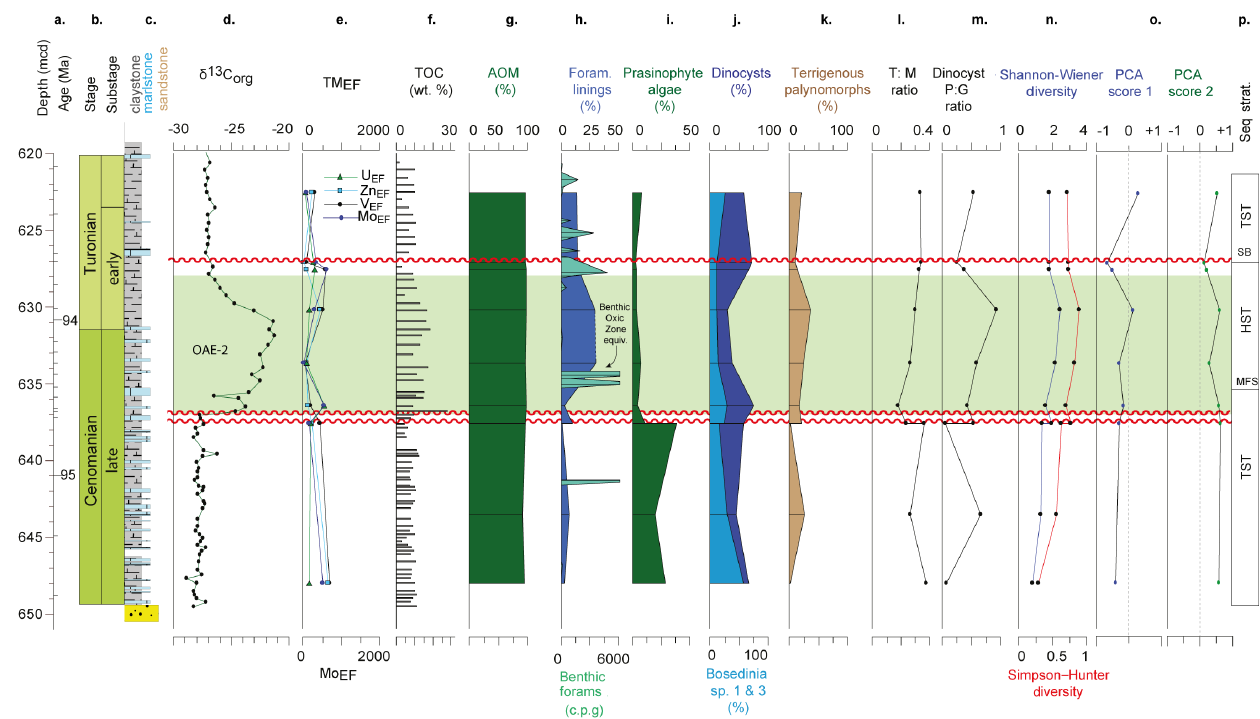
Figure 10. ODP Site 1261 data. Legend same as Fig. 4. δ 13 C org data from Erbacher et al. (2005) and Friedrich et al. (2008). Benthic foraminiferal abundance data from Friedrich et al.